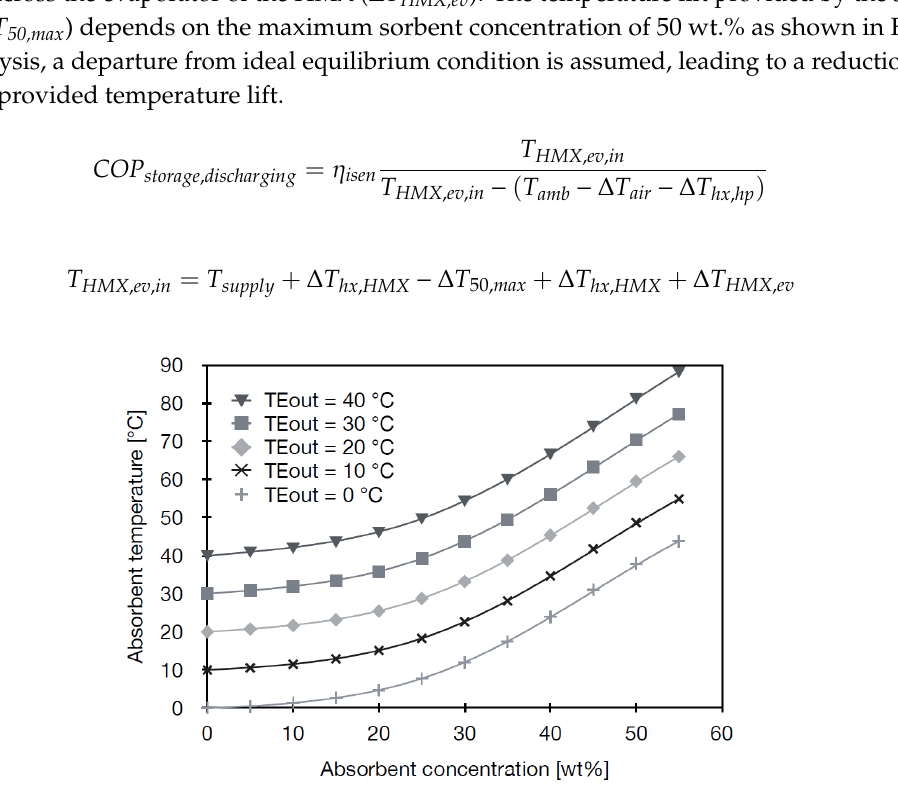
Figure 3. Ideal temperature lift provided between HMX evaporator temperature (TEout) and the maximum HMX absorber temperature by the sorption storage depending of maximum sorbent concentration. Adapted from [20].